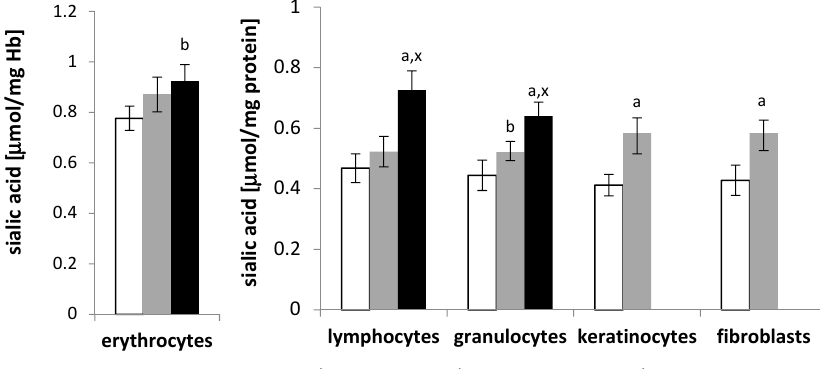
Figure 1. The sialic acid content in blood cells (erythrocytes, lymphocytes and granulocytes) as well as skin cells (keratinocytes and fibroblasts) of patients with psoriasis vulgaris ( n = 16) and psoriatic arthritis ( n = 8) as well as healthy subjects ( n = 8). Data points represent the mean ± SD; a—statistically significant di ff erences vs. healthy subjects, p < 0.0001; b—statistically significant di ff erences vs. healthy subjects, p < 0.05; x—statistically significant di ff erences vs. patients with psoriasis vulgaris, p < 0.01.